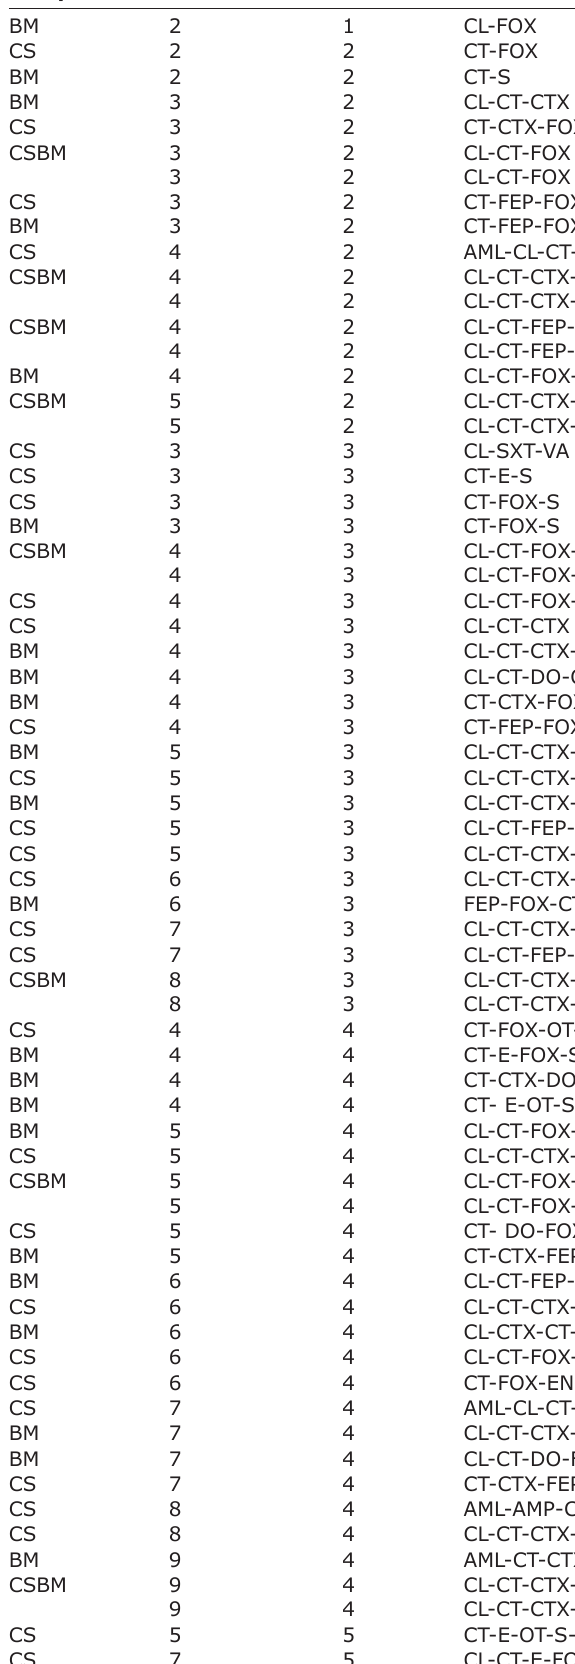
Table-3: Chicken cloacal swabs (CS) and Breast meat (BM) AMR 1 - Enterococcus profiles from local slaughterhouses in Nakhon Ratchasima Province, Thailand.